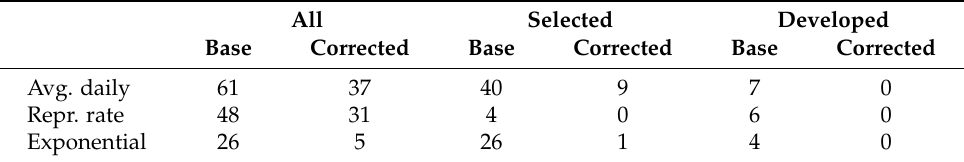
Table 5. The number of features that are statistically significant based on the class, dataset, and whether the correction, using Bonferroni adjustment (marked “Corrected”), is used or not—see Section